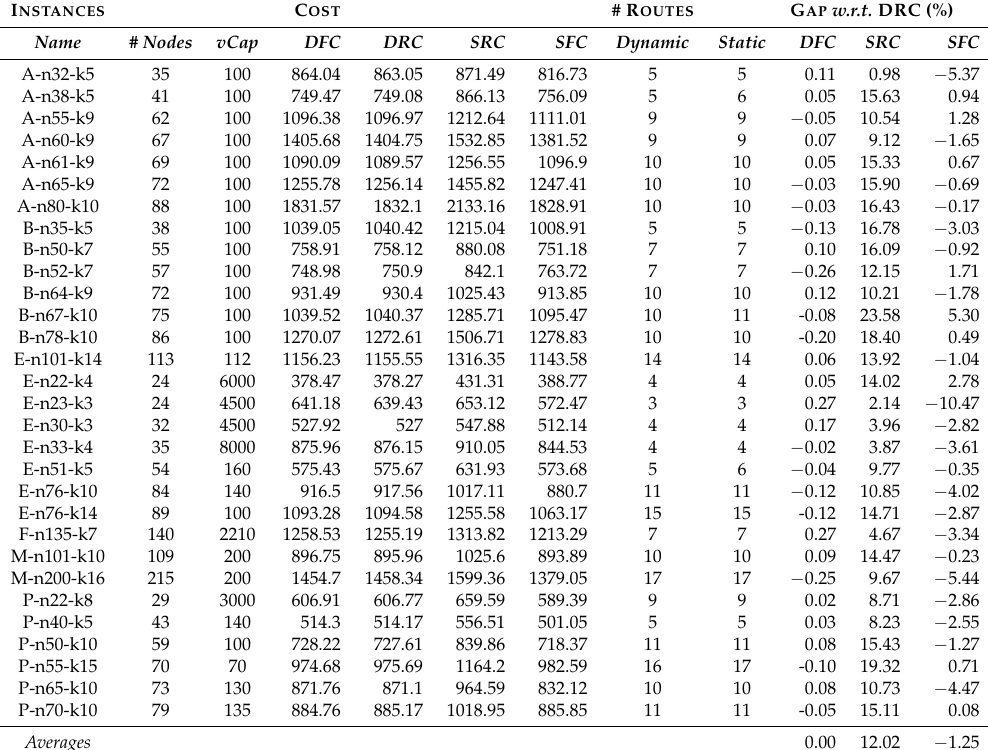
Table 1. Results for the static and dynamic approaches with a uniformly distributed error term (cid:101) ∈ [ − 10 − 3 ,10 − 3 ]